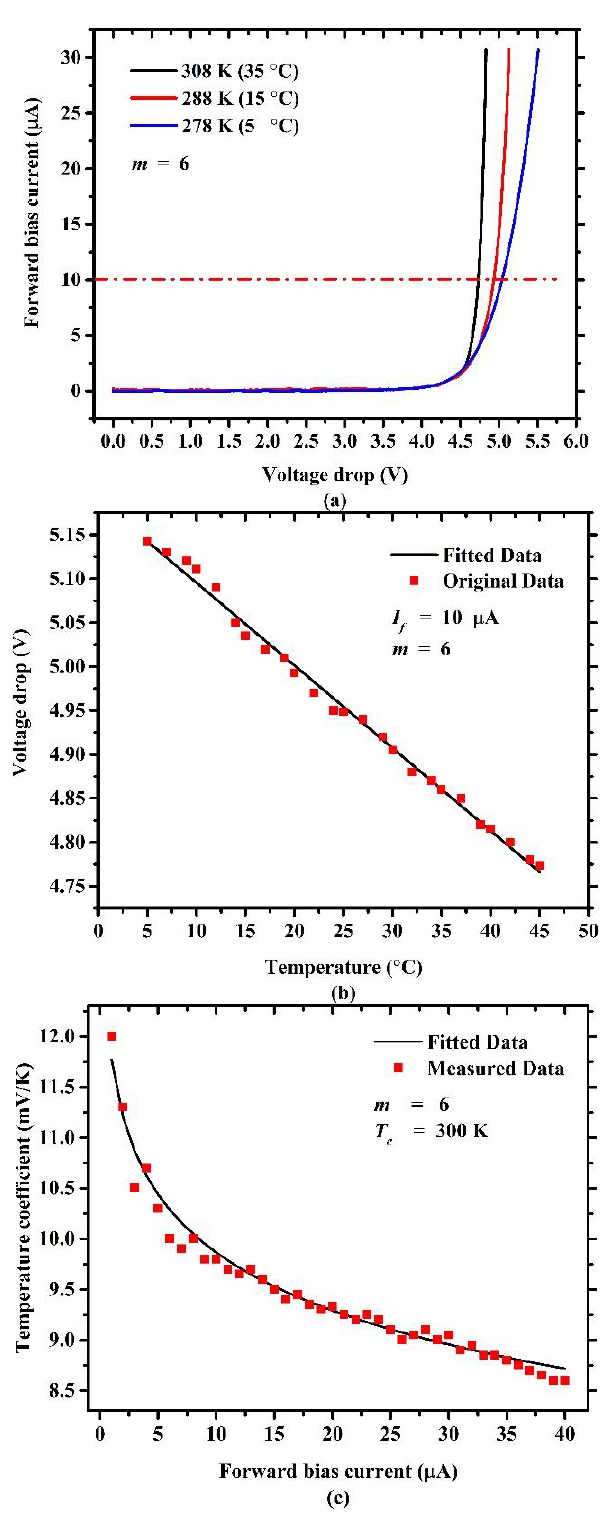
Figure 10. ( a ) Current–voltage (I–V) characteristics dependence on temperature. ( b ) Voltage drop dependence on temperature. ( c ) Temperature coefficient dependence on forward bias current of six series diodes.